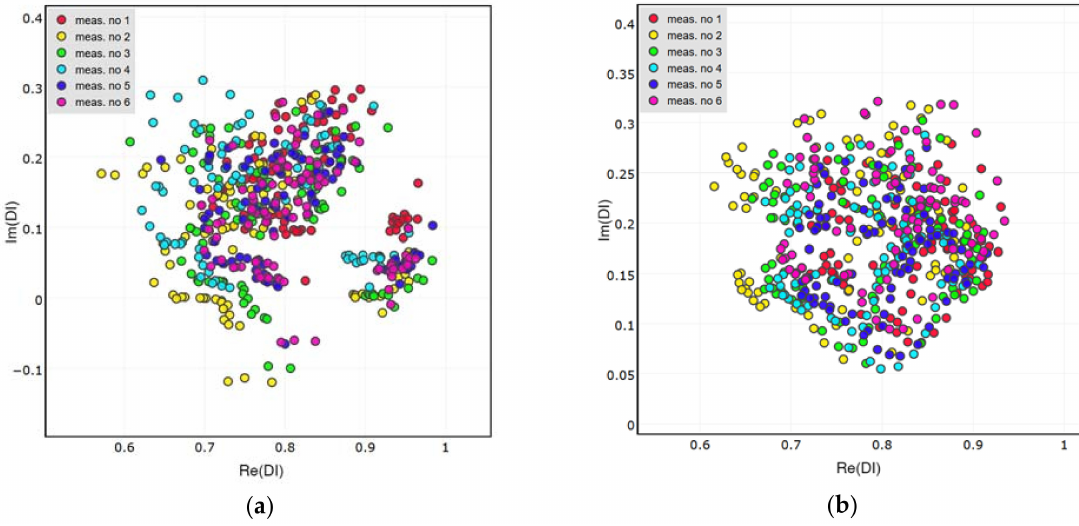
Figure 12. Damage Indices obtained for simulated damage on sensing path G-S2: ( a ) Attached network; ( b ) Embedded